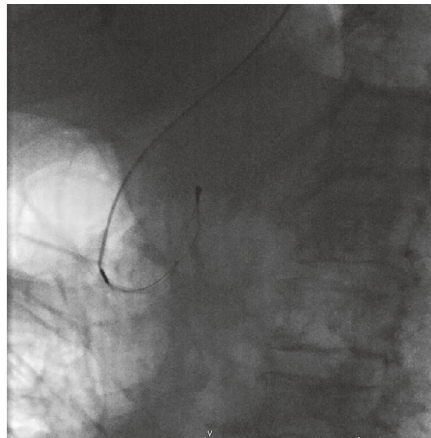
Figure 2: Dormia basket in CBD, after handle has broken (endo- scope has been removed pending urgent surgery).